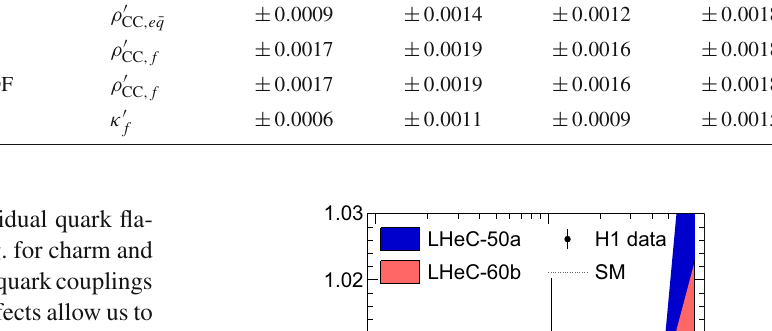
Table 8 Expected uncertainties of anomalous CC coupling parameters ρ (cid:9) and ρ (cid:9) CC , eq CC , e ¯ q from 2-parameter (upper part) and 1-parameter fits (lower part). The last two lines show the results from a fit combining the CC parameter ρ (cid:9) with the CC NC κ (cid:9) parameter (see Eq. (30))